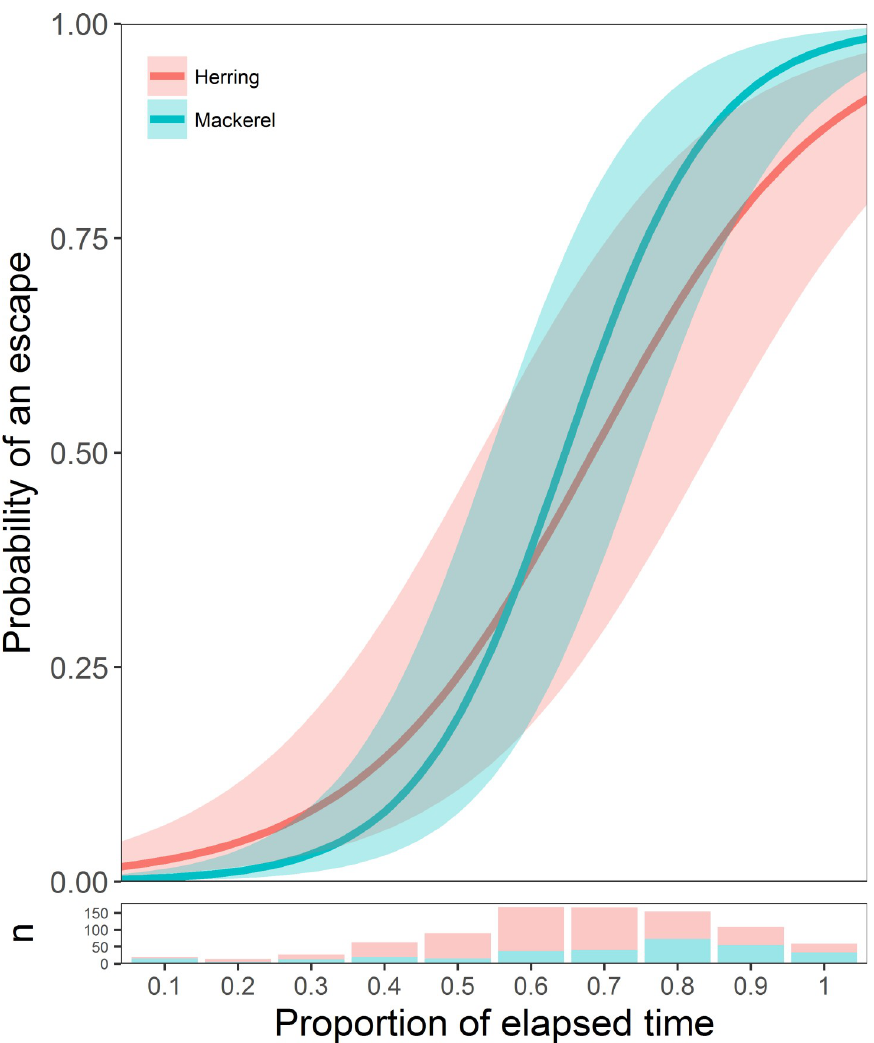
Fig 5. Probability of escape as a function of time. Estimated probability (with 95% confidence intervals) of a purse seine escape of any kind over time, for mackerel and herring. The lower panel shows the number of observed escape events per tenth-part of elapsed time. The dataset includes observations from both Vessel A and Vessel B.